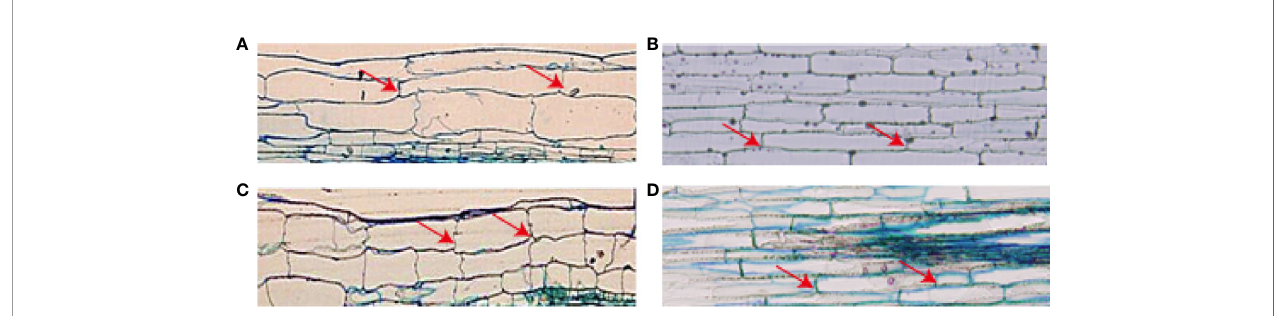
FIGURE 3 | Microstructure of hypocotyl in tobacco (A, C) /mesocotyl in rice (B, D) cells of wild-type and ZmMYB59 transgenic plants. A-Wild-type tobacco. C-T 2 generation transgenic tobacco. B-Wild-type rice. D-T 2 generation transgenic rice. The image is a 4 × fl uorescence microscope, and the arrow refers to the longitudinal boundary position of the